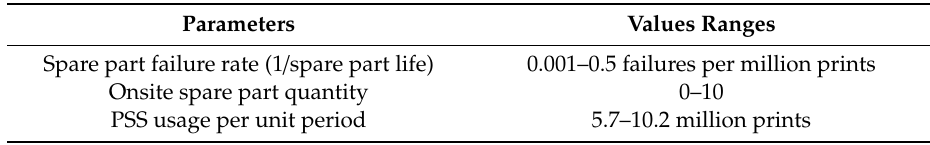
Table 1. Key parameters and their value ranges for simulation and optimization.